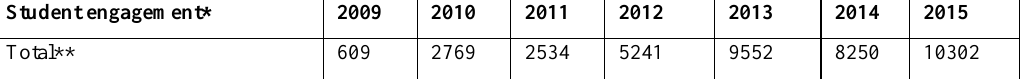
Table 1: Students associated with the increased engagement with partner schools 2009 – 2015 Student